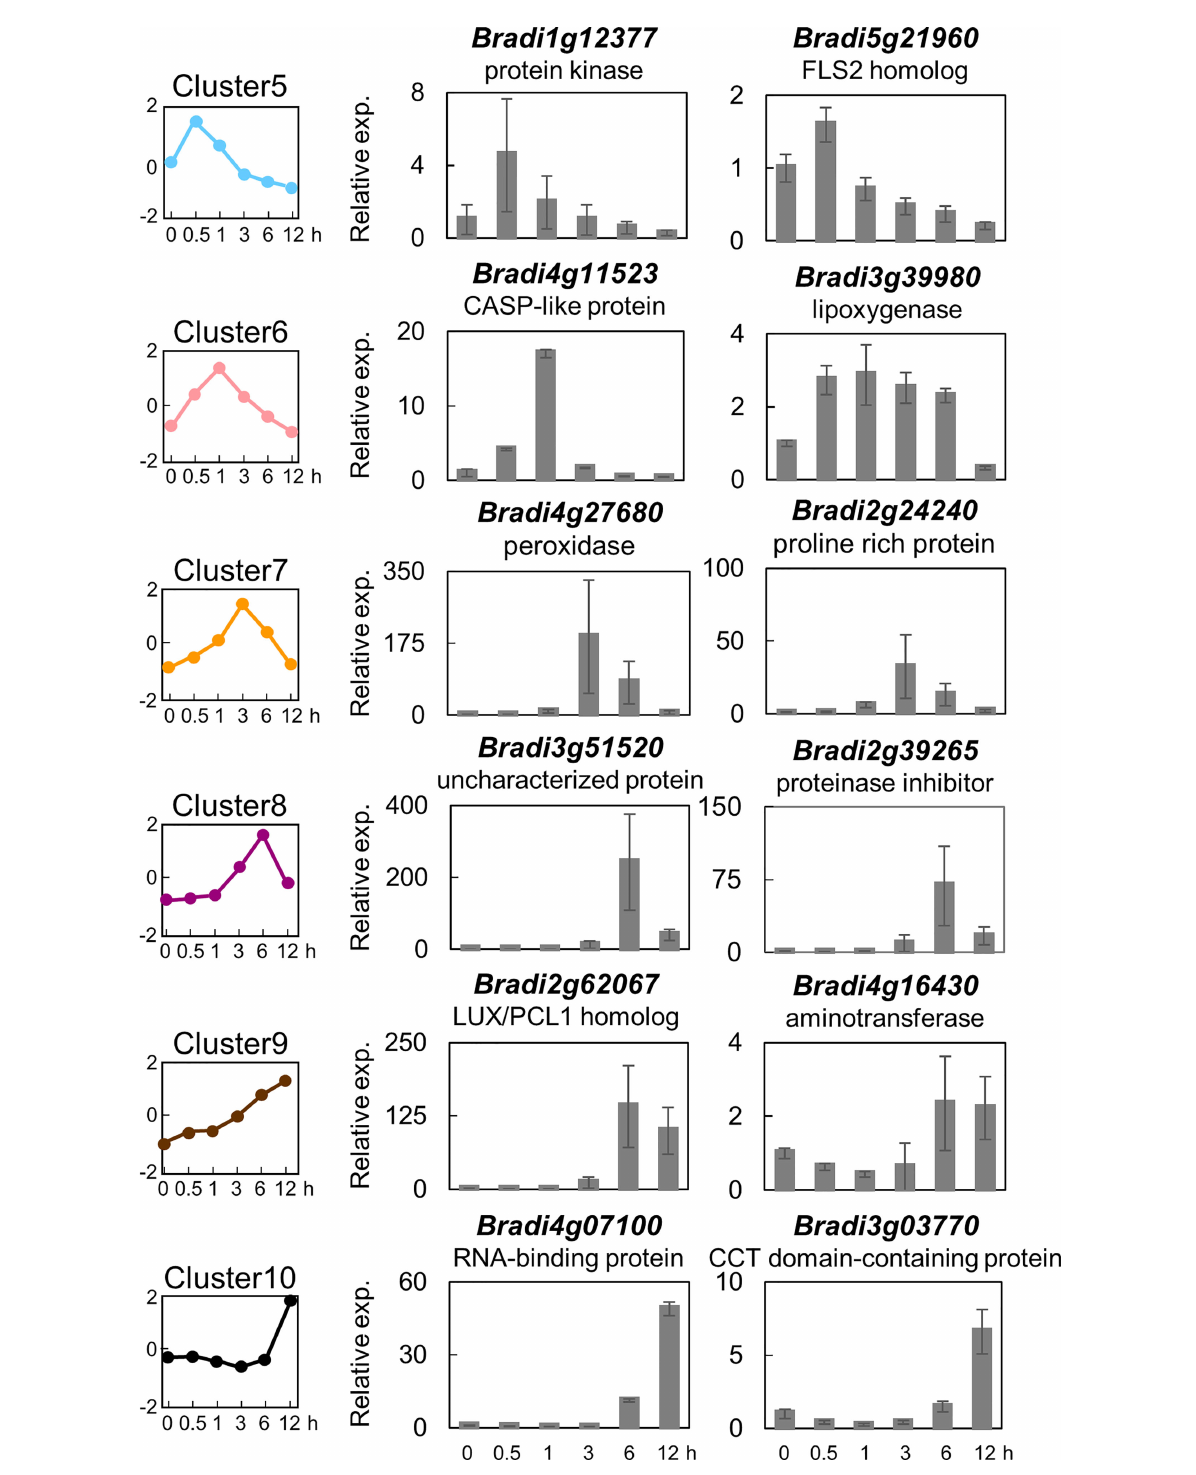
FIGURE 3 Expression analysis of selected fl g22-responsive marker genes of Brachypodium distachyon representing the different clusters. Two genes each were selected from clusters 5 – 10, and their expression was analyzed by qRT-PCR using cDNA prepared from total RNA extracted from B distachyon leaf disks sampled at each time point after fl g22 (500 nM) treatment. Data represent mean ± SE ( n =